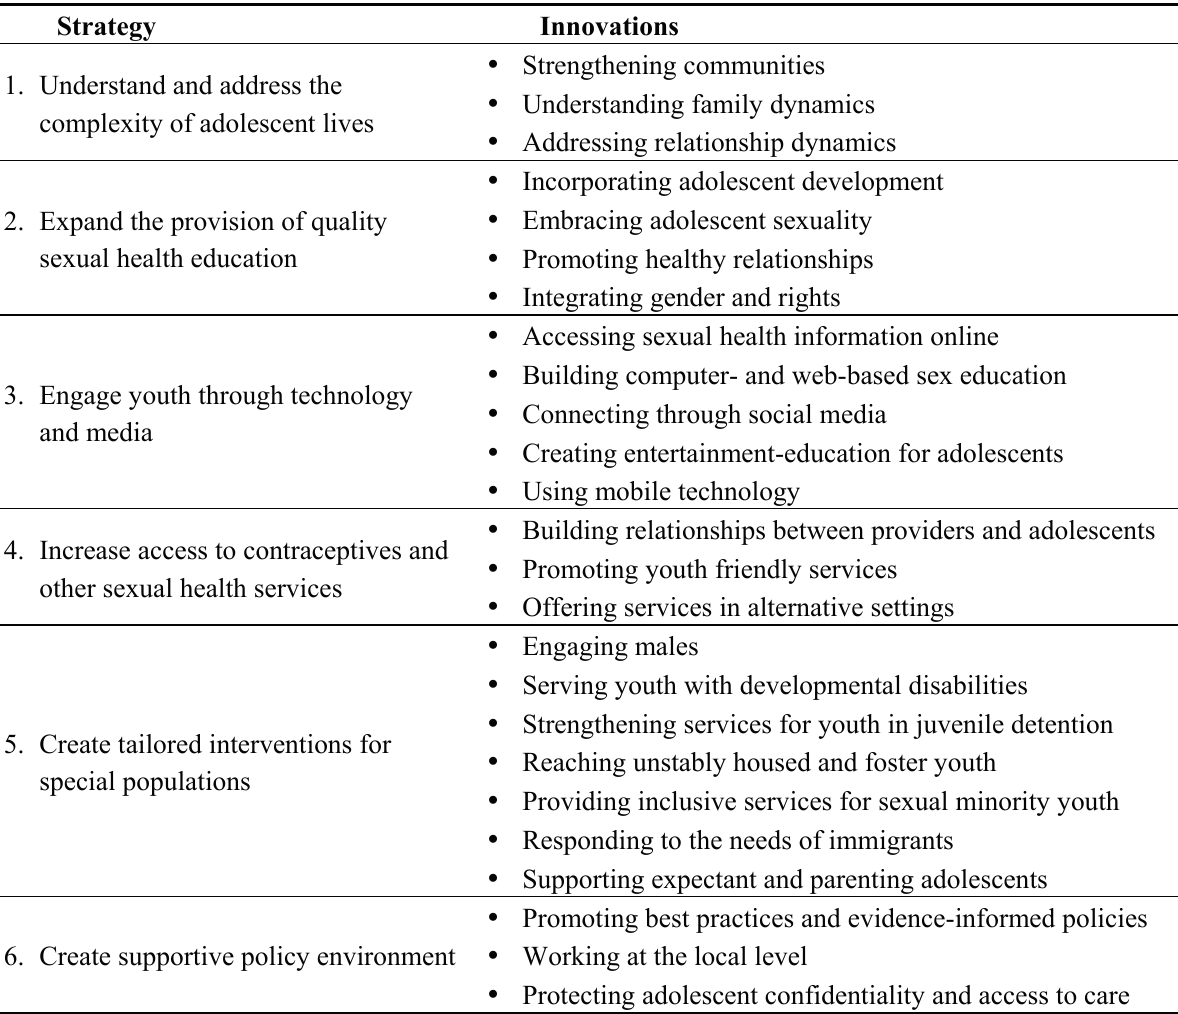
Table 1. Summary of key strategies to promote adolescent sexual health and examples of innovations from research and